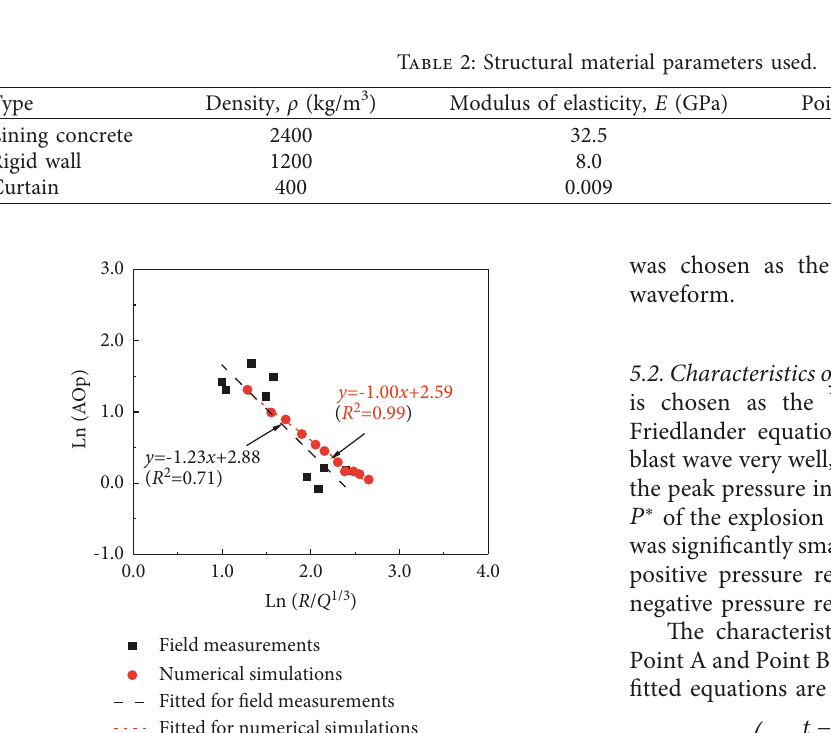
Figure 8: Comparison of measured with numerical simulations.